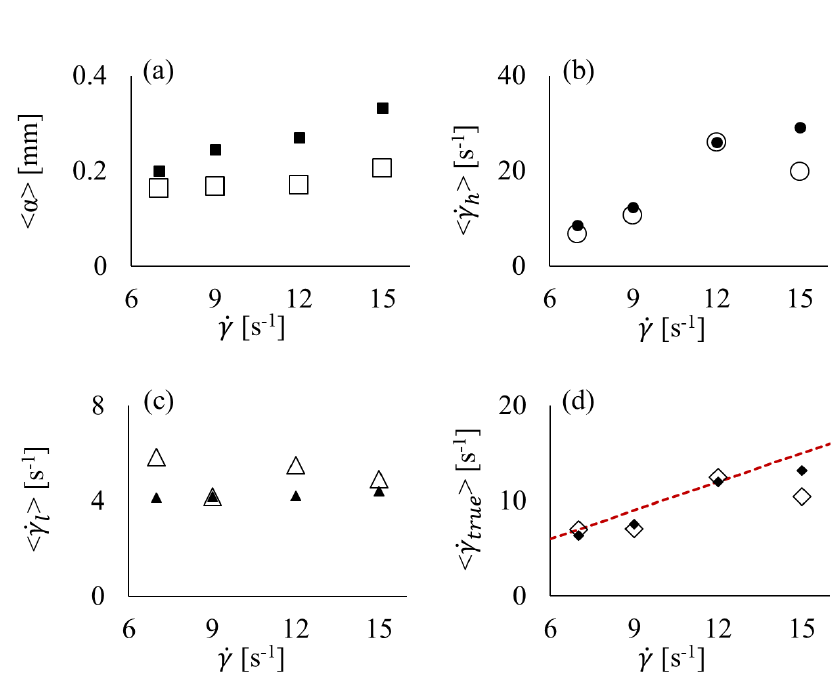
Figure 8: Shear banding characteristics averaged over the last ~120 s of the shear startup experiment, where the flow is at steady state, as a function of applied shear rate for protocol 1 (filled symbols) and protocol 2 (open symbols). Error bars of the standard deviation reflecting the fluctuations in time are smaller than the symbol size. (a) the interface position α (b) the shear rate in the high shear band ˙ 𝛾 shear rate in the low shear band ˙ 𝛾 and (d) the true shear rate ˙ 𝛾 , which is a measure of apparent wall slip. The dashed red line is where l true ˙ 𝛾 true = ˙ 𝛾 app and values on this line indicate no slip